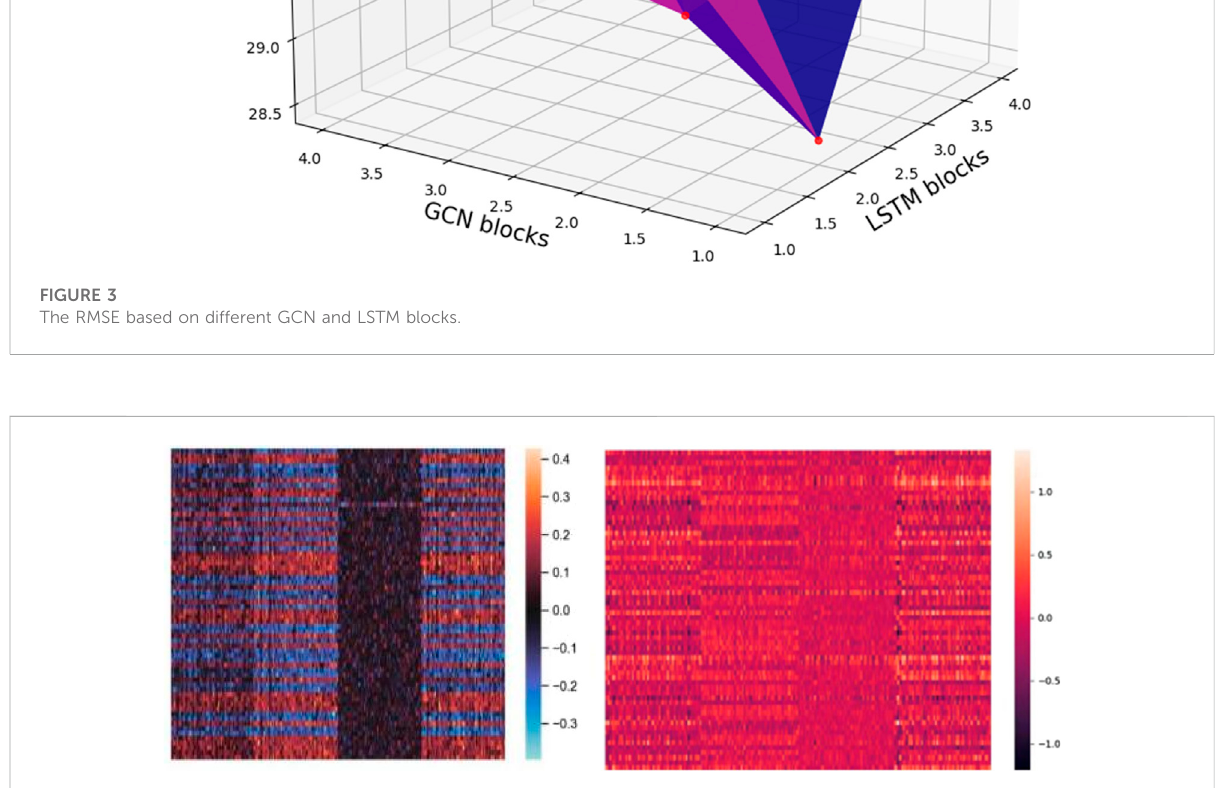
FIGURE 4 The weights change between LSTM